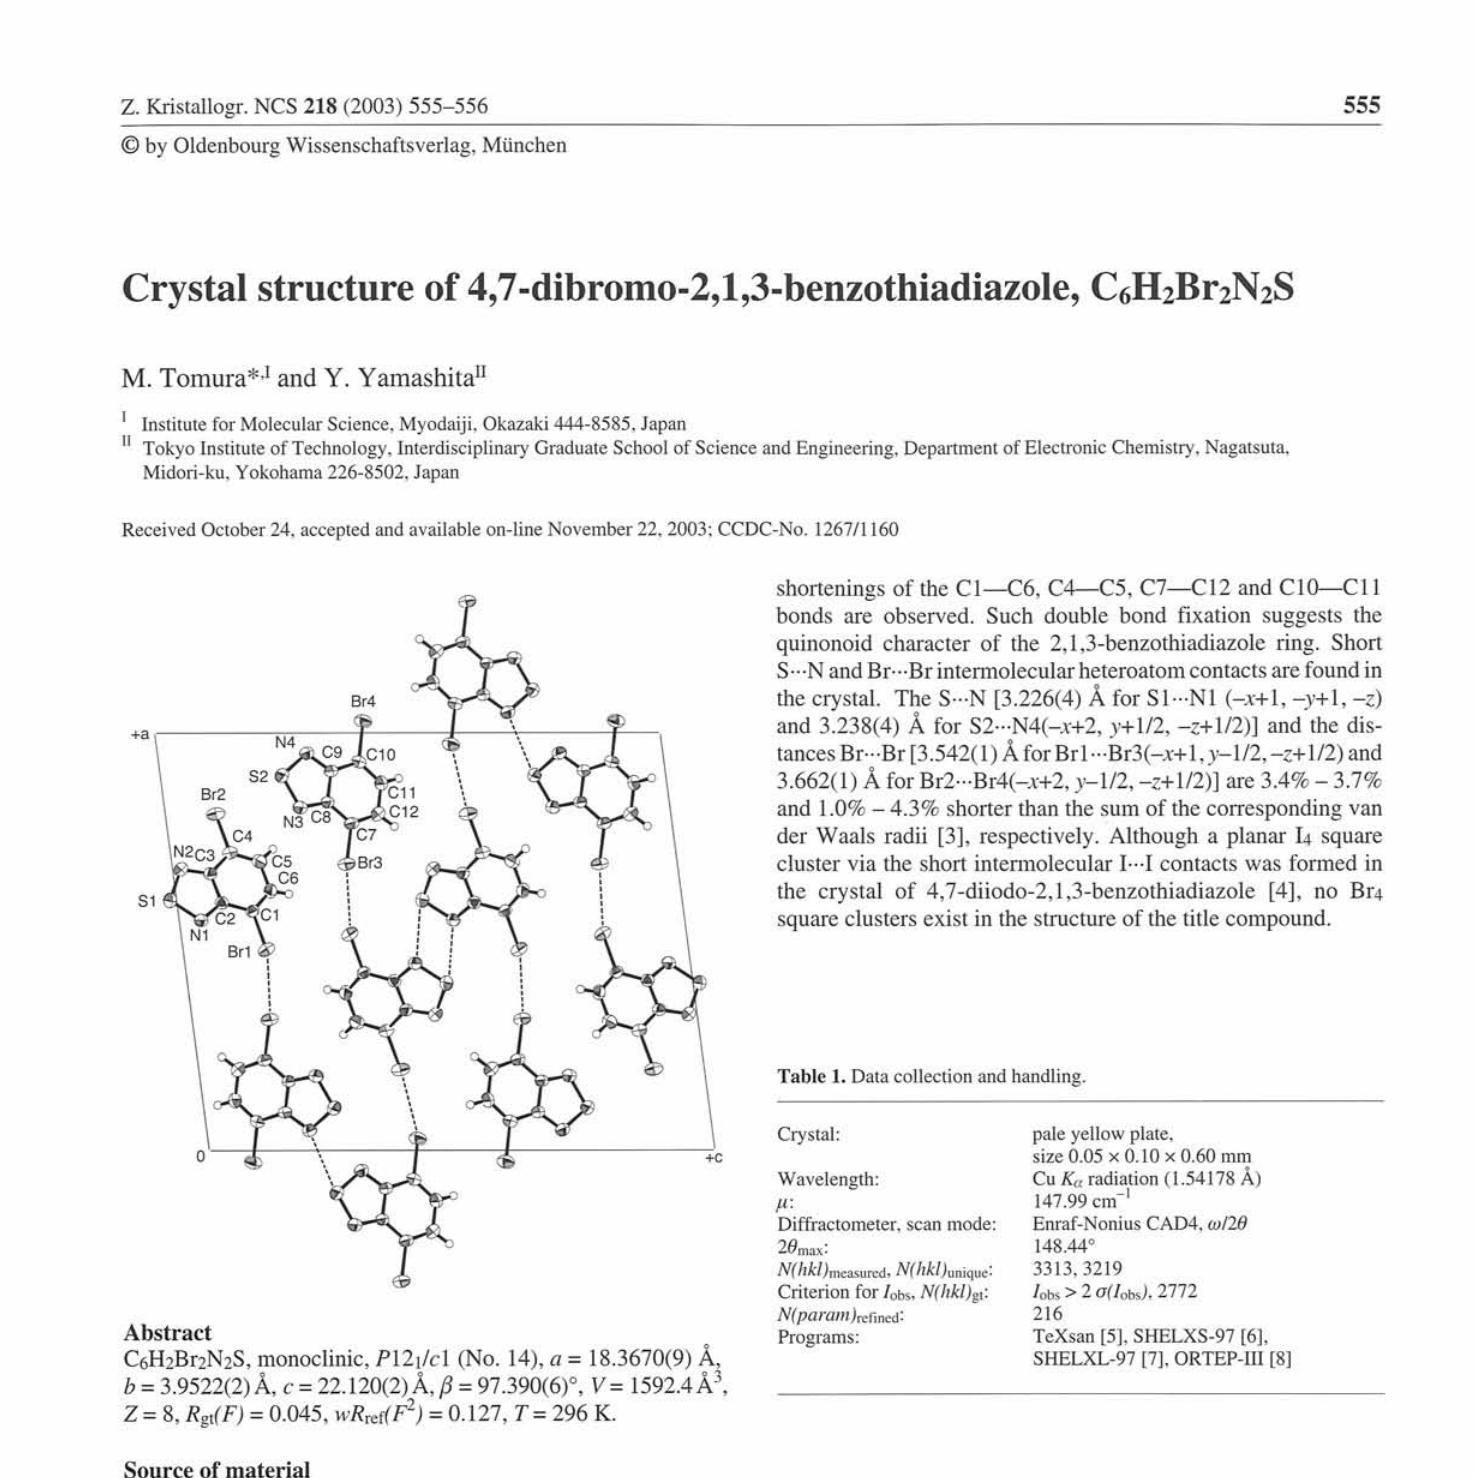
Table 2. Atomic coordinates and displacement parameters (in Â 2